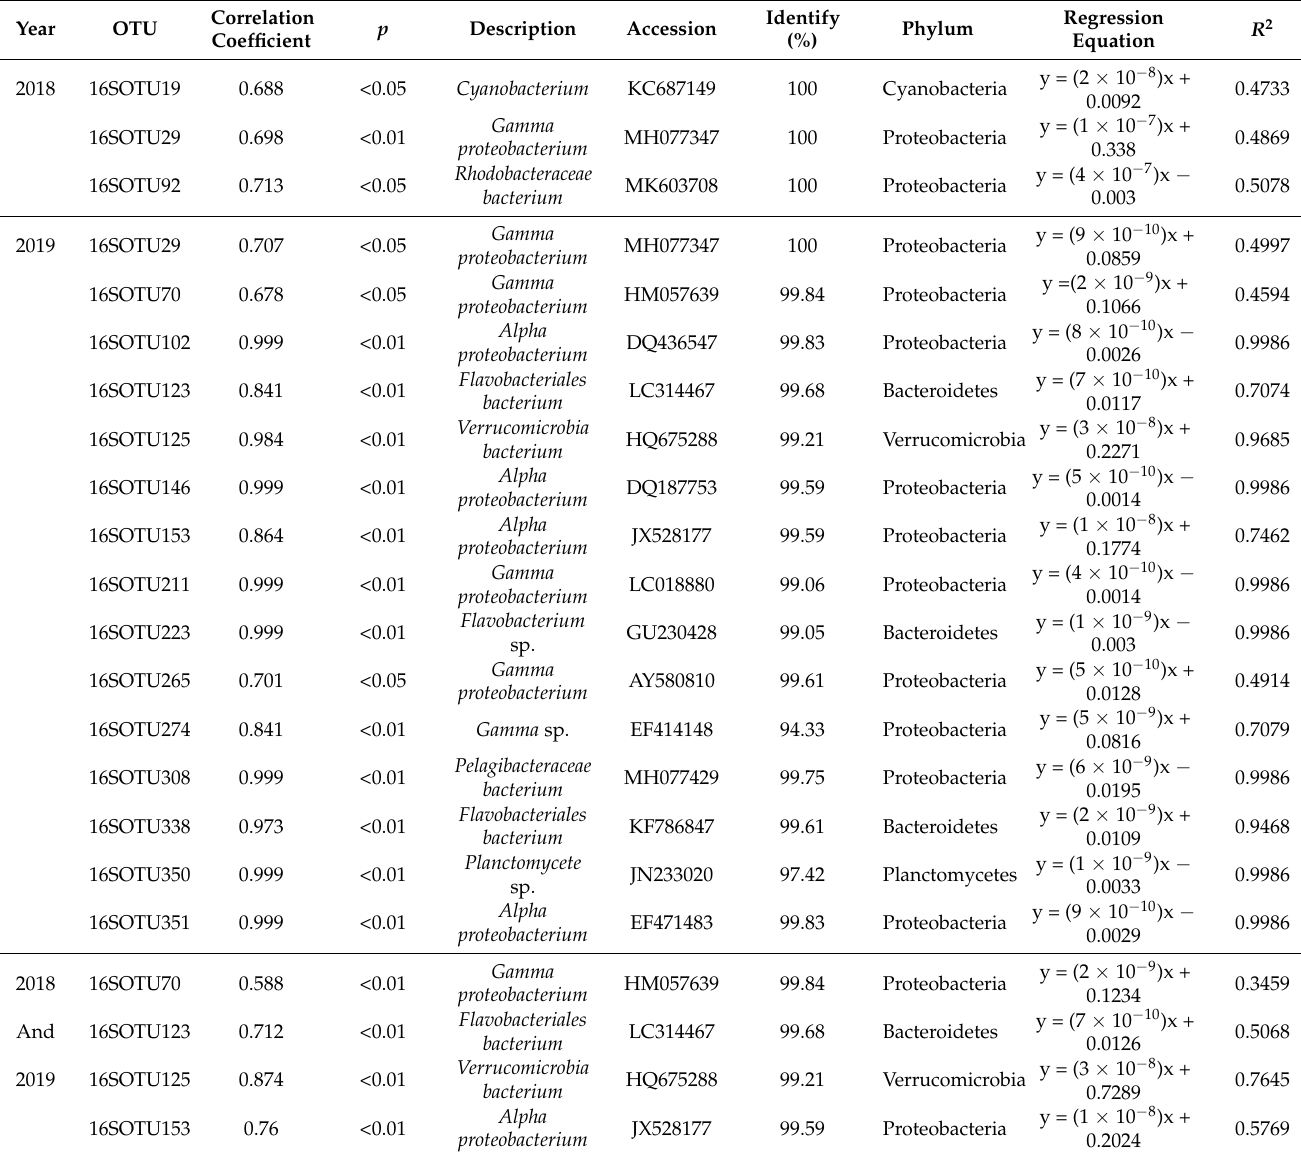
Table 7. Microbial OTUs strongly correlated with C. polykrikoides